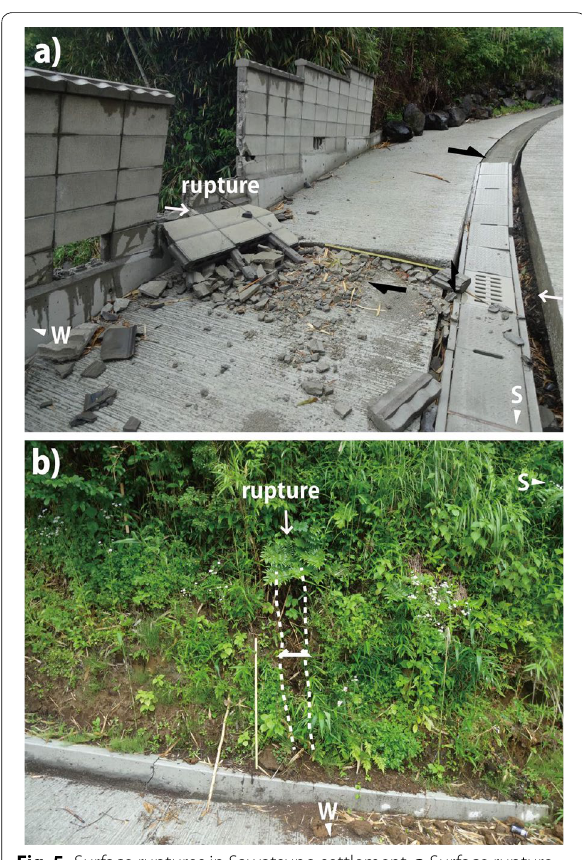
Fig. 5 Surface ruptures in Sawatsuno settlement. a Surface rupture with 10 cm right strike-slip and 15 cm south side down at Site 11; b surface rupture with 23 cm opening at Site 12 with N86°W strike and 84°S